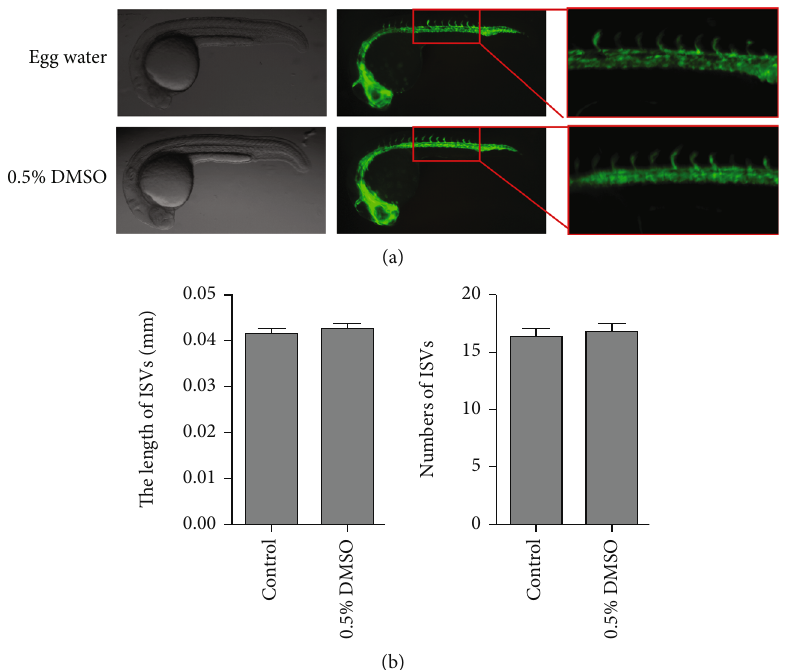
Figure 1: E ff ect of 0.5% DMSO on the growth of intersegmental vessels (ISVs) in the zebra fi sh model. (a) Bright- fi eld and fl uorescent images of zebra fi sh embryos at 24 h postfertilization (hpf) treated with egg water and 0.5% DMSO. (b) Average length and number of ISVs in zebra fi sh treated with di ff erent